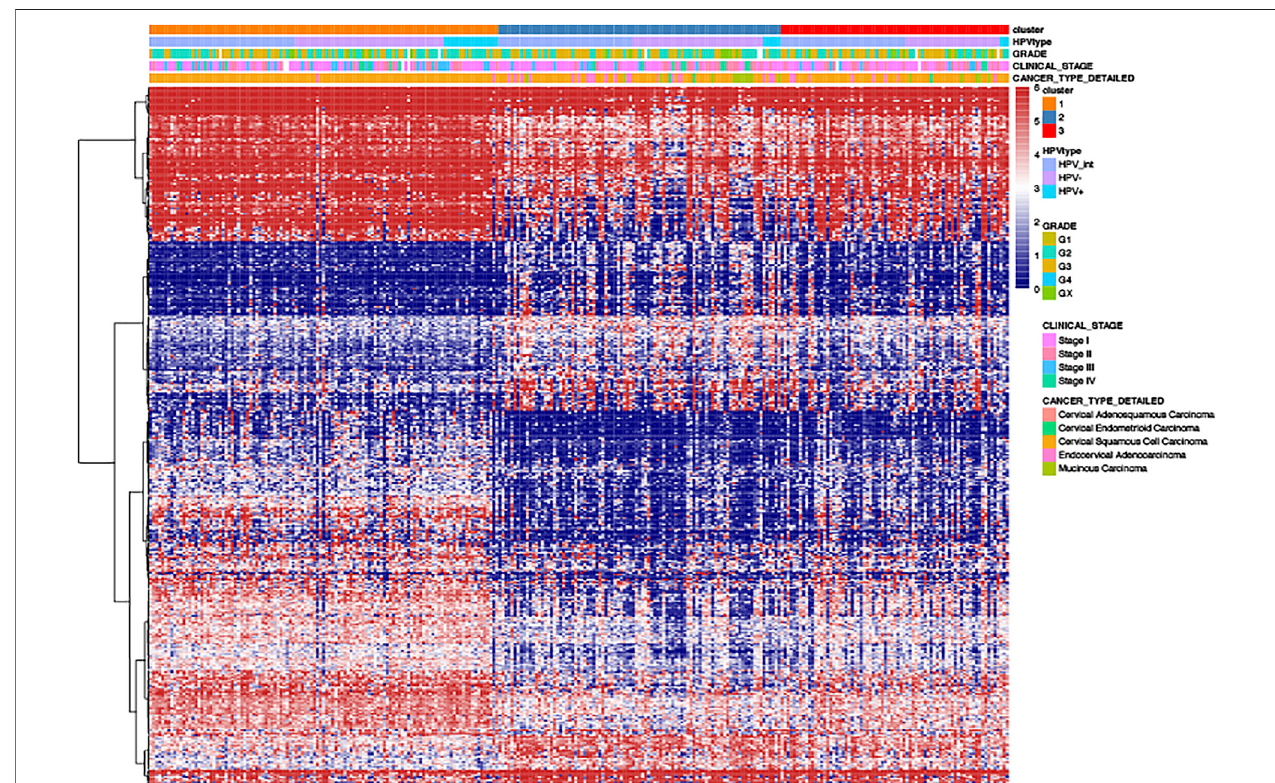
FIGURE 6 | The heat-map of differential gene distribution in cervical cancer strati fi ed by HPV related clusters, HPV status, grades, stages, pathological types.